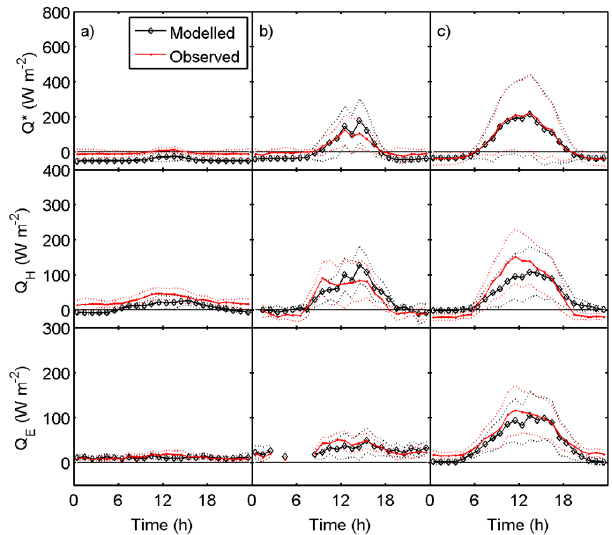
Figure 10. Diurnal behaviour of the measured and modelled net all-wave radiation ( Q ∗ ) and turbulent energy fluxes ( Q H and Q E ) during (a) cold snow, (b) melting snow and (c) snow-free periods in Helsinki in 2012. Only hours when observations are available were accounted for. Dotted lines show the quartile